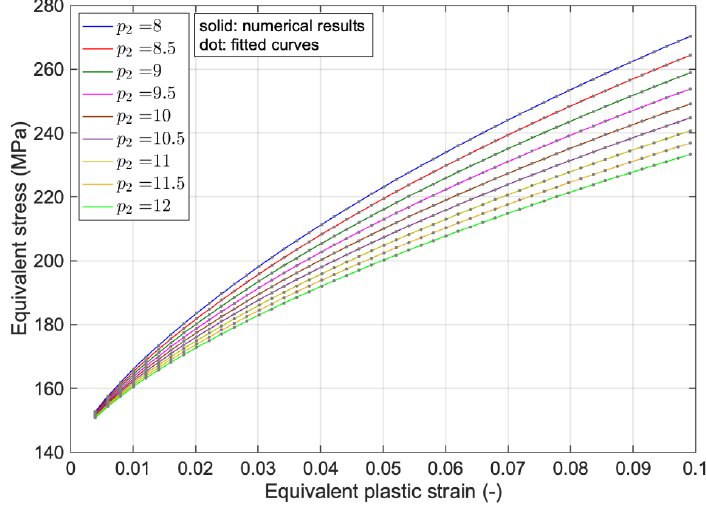
Figure 9. Comparison between numerical results and fitted curves with change in p